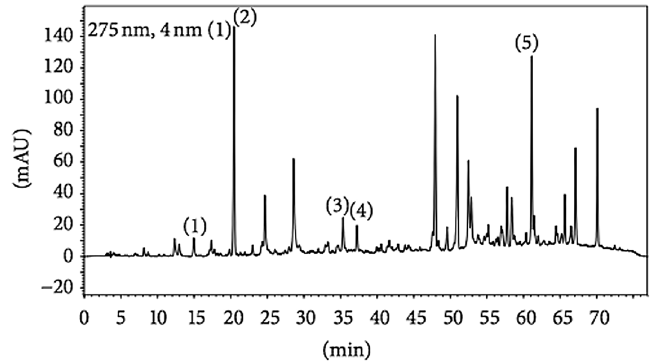
Figure 1. Fingerprint analysis of the ethanol extract of propolis. Chromatograms were plotted at 275 nm with reverse-phase high-performance liquid chromatography on a C18 column (4.6 mm × 250 mm; particle diameter, 5 µm; pore diameter, 100 Å) and gradient elution with methanol and acidic water (pH 2.7). The chromatographic profile includes the following compounds: (1) caffeic acid phenethyl ester (in approximately 15 min); (2) p -coumaric acid (in approximately 20 min); (3) trans-Cinnamic acid (in 35–36 min); (4) aromadendrin (in 38 min); and (5) artepillin C (in 61–62